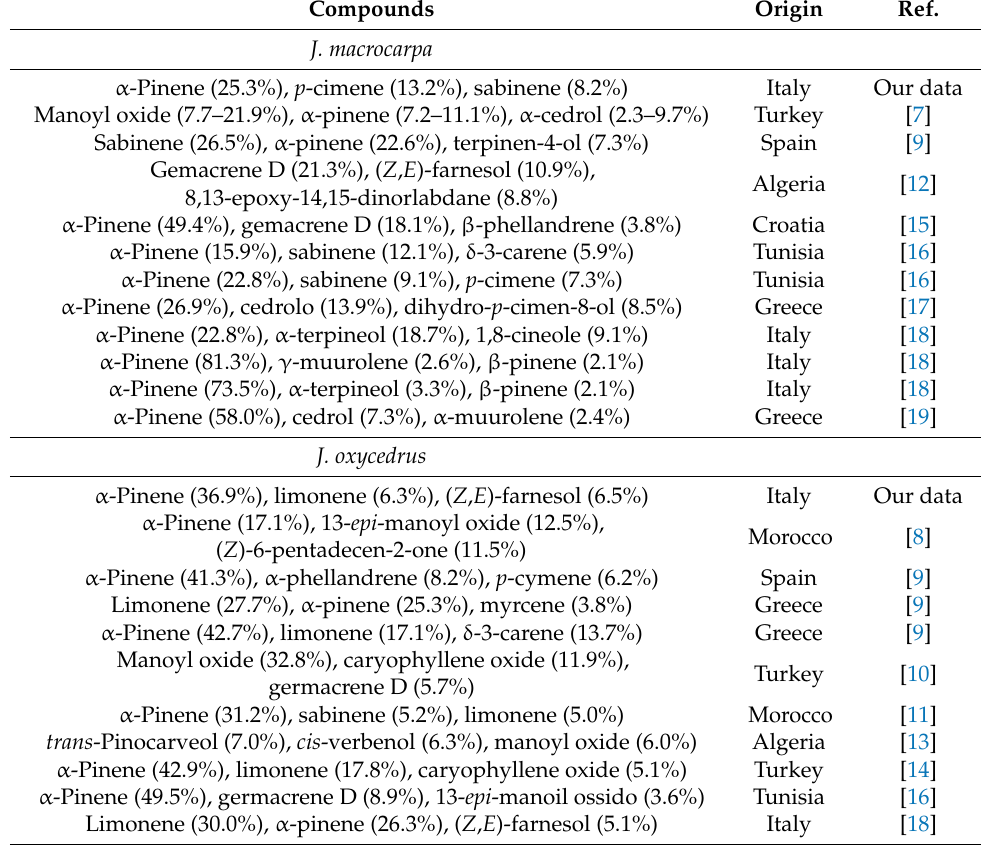
Table 5. The dominant volatiles of J. macrocarpa and J. oxycedrus essential oils from data in the literature. Compounds Origin